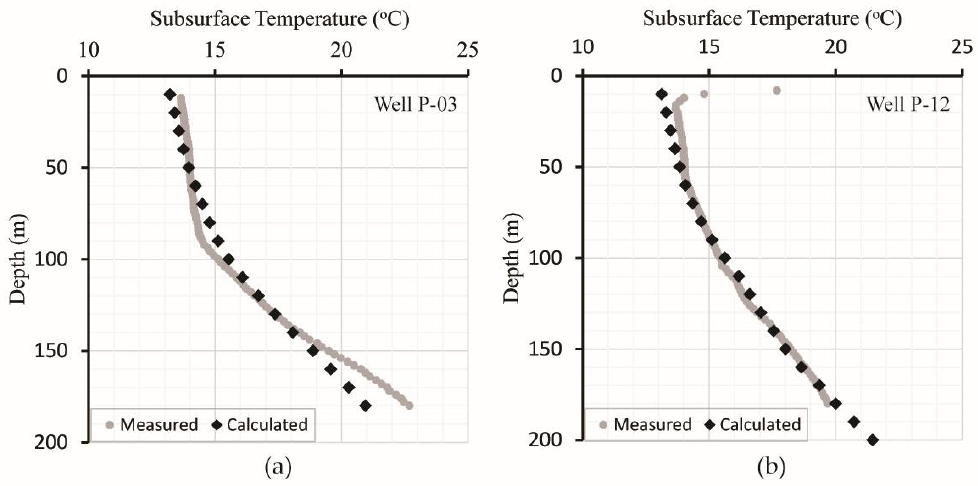
Figure 4. Comparison of calculated underground temperature distribution with measured values. ( a ) Comparison for Well P-03; ( b ) comparison for well P-12. Reprinted by permission from Springer Customer Service Centre GmbH: Springer HYDROGEOLOGY JOURNAL (Performance evaluation of a ground-source heat pump system utilizing a flowing well and estimation of suitable areas for its installation in Aizu Basin, Japan, Shrestha et al., 2017).